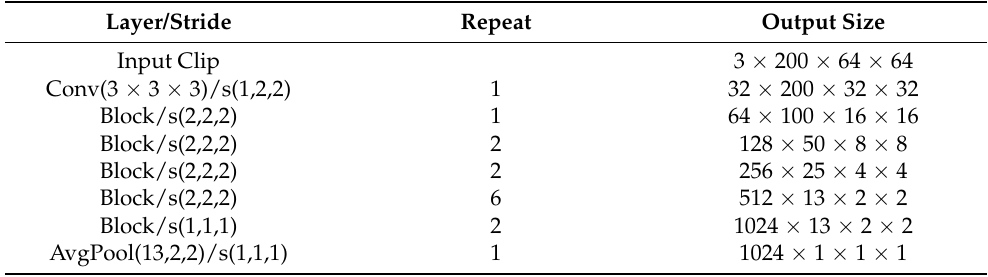
Table 1. 3D-MobileNet architecture.